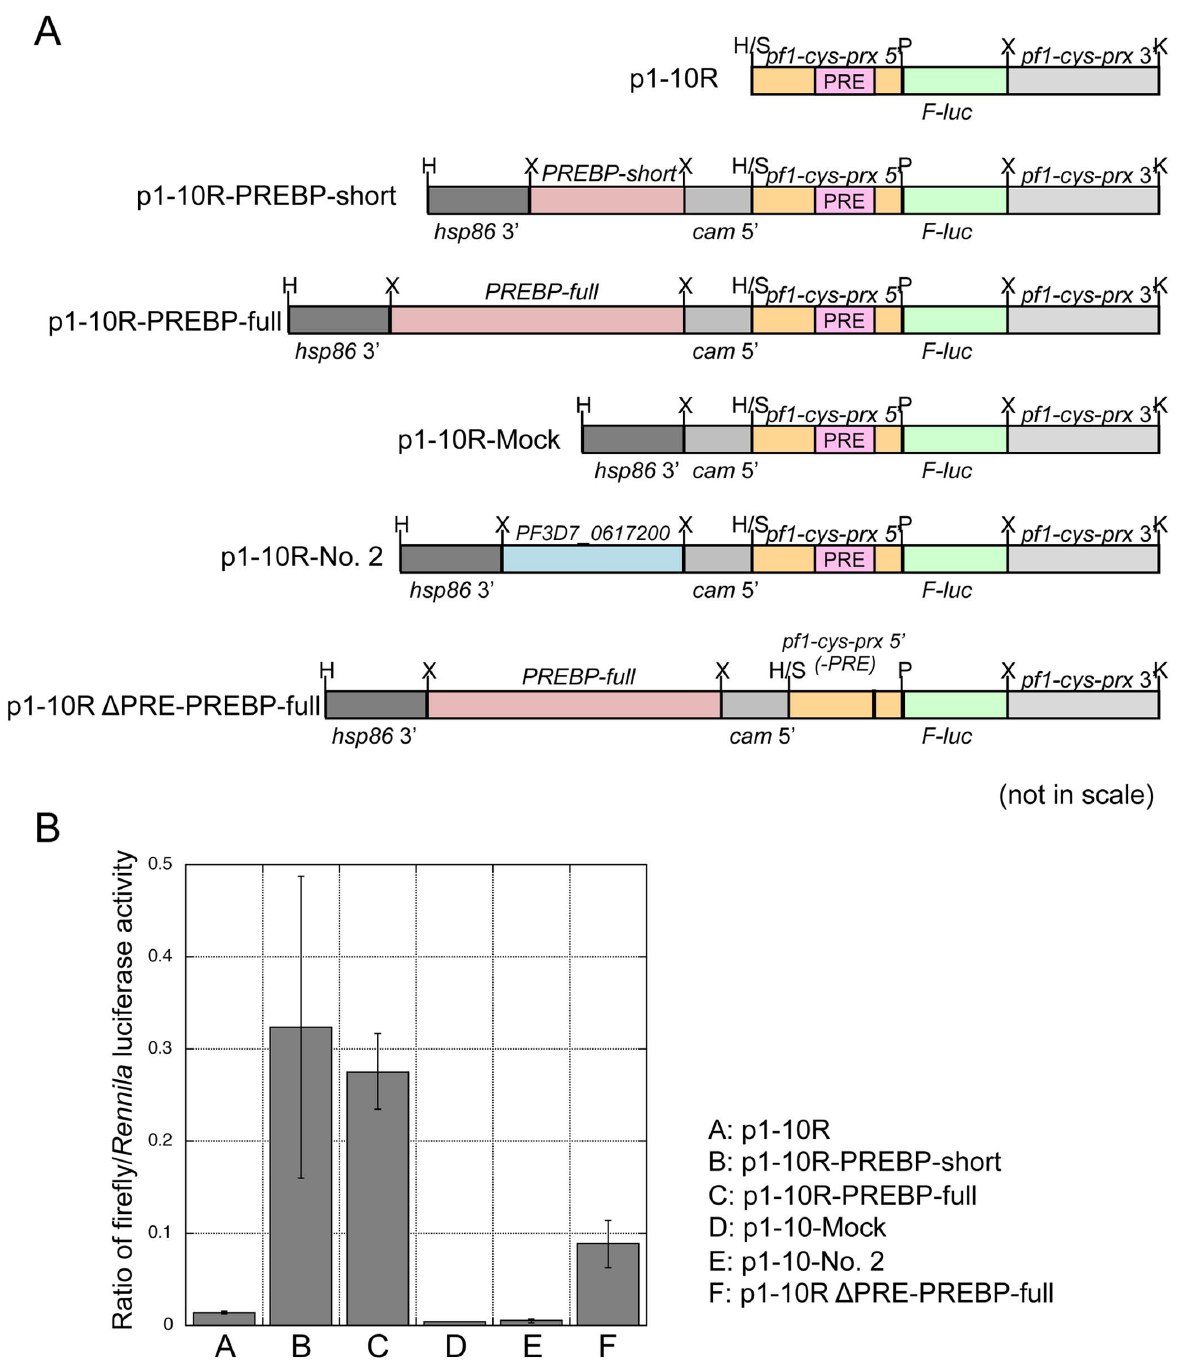
Figure 6. PREBP is critical for the expression of the reporter gene under the pf1-cys-prx promoter. (A) Schematic diagram of plasmid constructs used for the transient luciferase assay in P. falciparum . The restriction endonuclease recognition sequences shown are E, EcoR I; H, Hind III; K, Kpn I; P, Pst I; S, Sbf I and X, Xho I. (B) The dual luciferase assay. The plasmids shown in Figure 6A were transfected into the parasite synchronized in ring stage. For the dual luciferase assay the pHC1-Rluc plasmid, which expresses Rennila luciferase, was co-transfected in each assay. After 20–24 h, the luciferase activities of the transfected parasites were measured and the ratio of firefly/Rennila luciferase activity was calculated. The data are indicated as means of three independent assays with standard deviation. doi:10.1371/journal.pone.0074701.g006 activity of the transfectant of the original plasmid, 1–10R-PREBP- Discussion full ( P , 0.01, Figure 6B). Here, we report for the first time the purification and identification of a specific cis -element binding protein from the